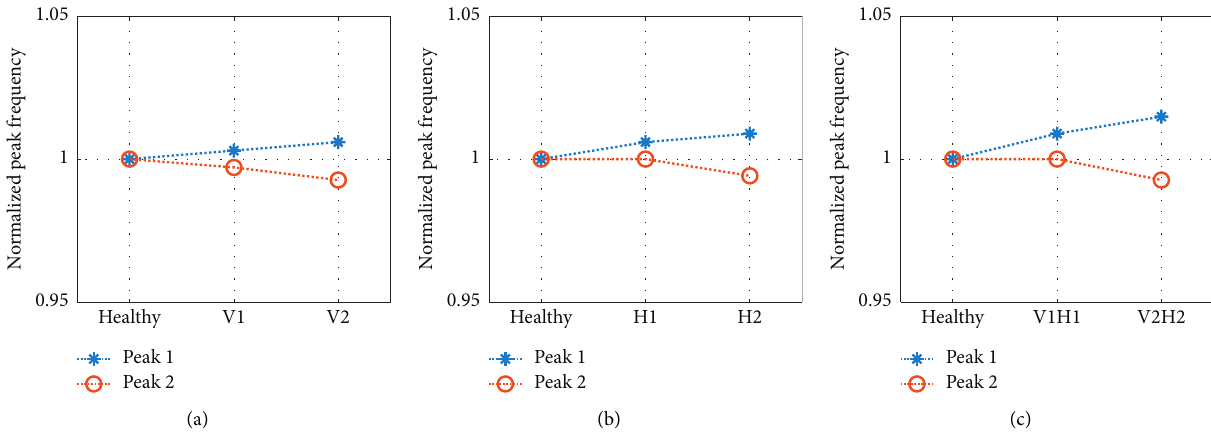
Figure 24: Shifts in peak frequencies caused by PZT breakage defects. (a) Cases: V1, V2. (b) Cases: H1, H2. (c) Cases: V1H1, V2H2.